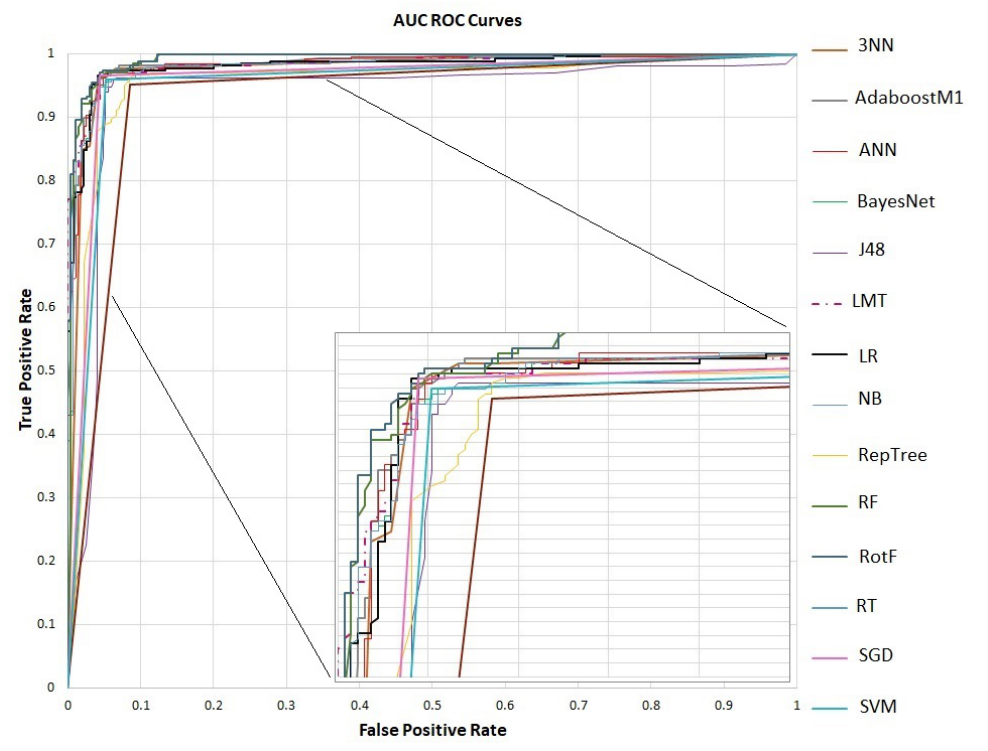
Figure 2. Models Evaluation Based on AUC ROC